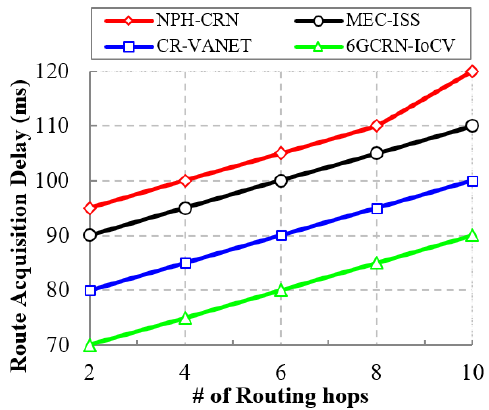
Figure 14. Routing acquisition delay vs. the number of routing